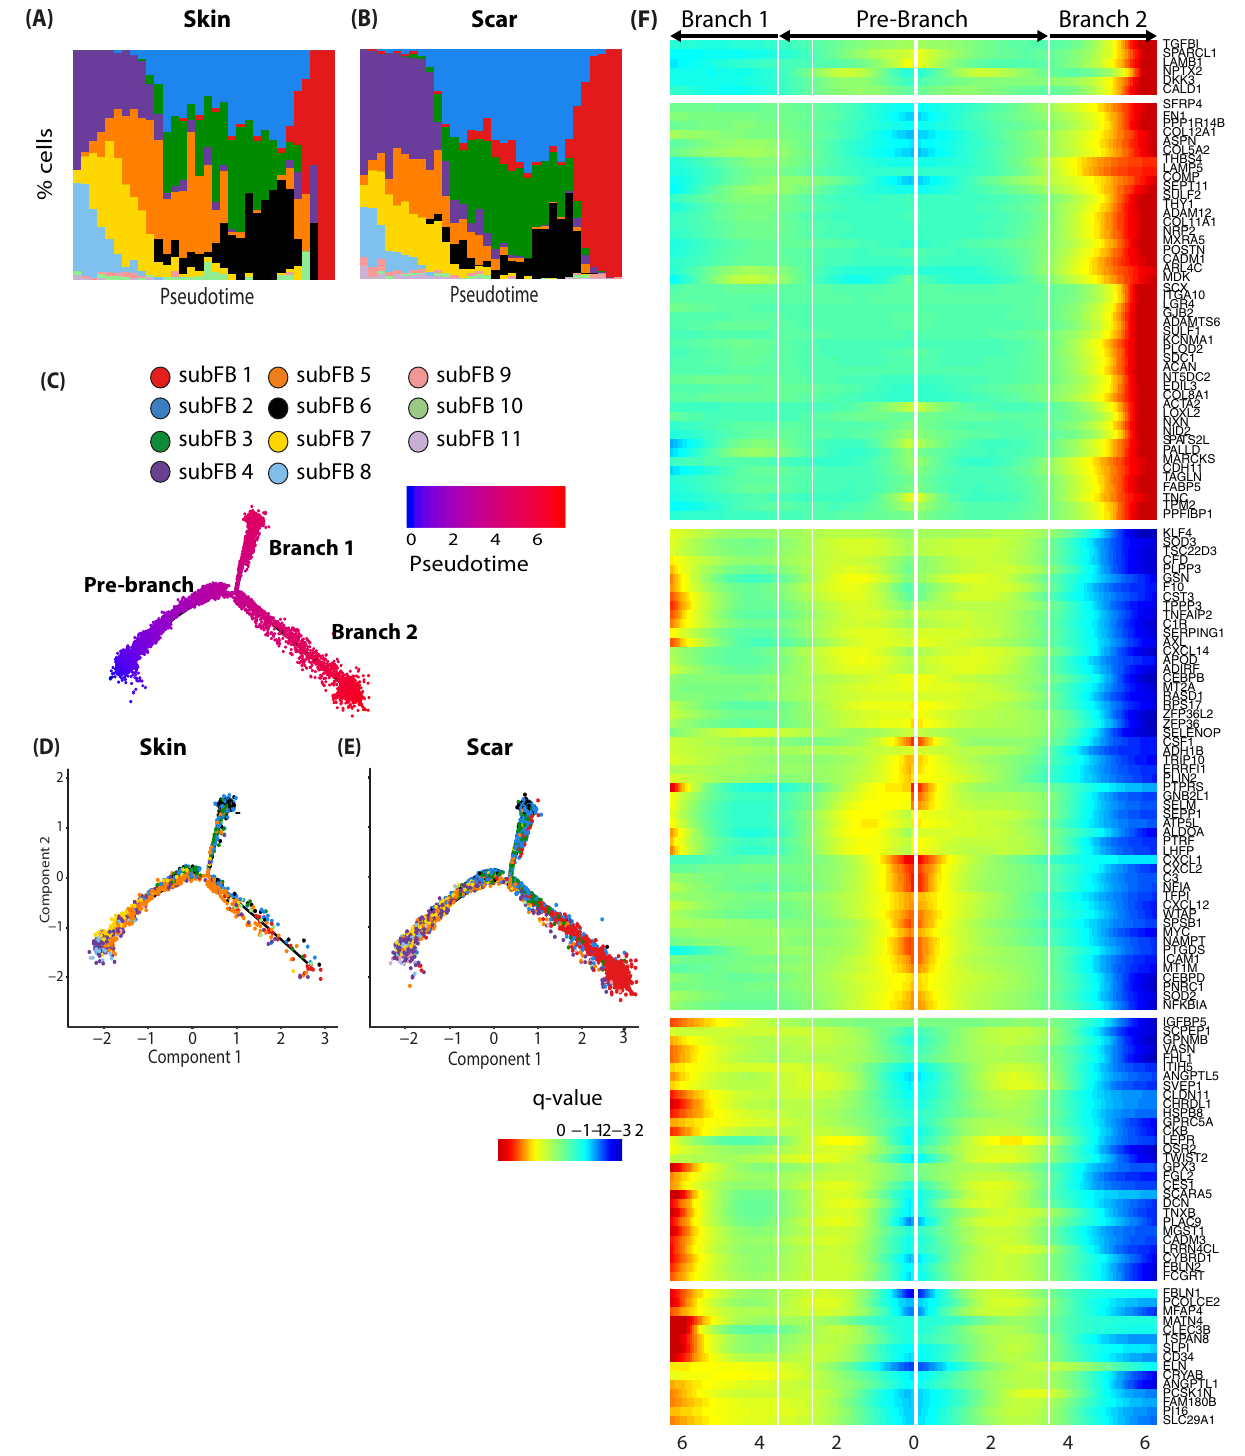
Fig. 3 Pseudotime analysis of human scar FBs identi fi es cell fates and pseudotime-regulated genes. A , B Ordering skin and scar FBs along a pseudotime axis. X -axis, pseudotime. y axis, % of cells in respective pseudotime-bin. Cell trajectory with pre-branch and branches is shown. C Color code represents pseudotime progression. D , E Cell trajectories were calculated based on pseudotime values, split by tissue. F Branched expression analysis modeling (BEAM) of skin and scar fi broblasts. Colors represent q -value, the expression of the respective gene in relation to